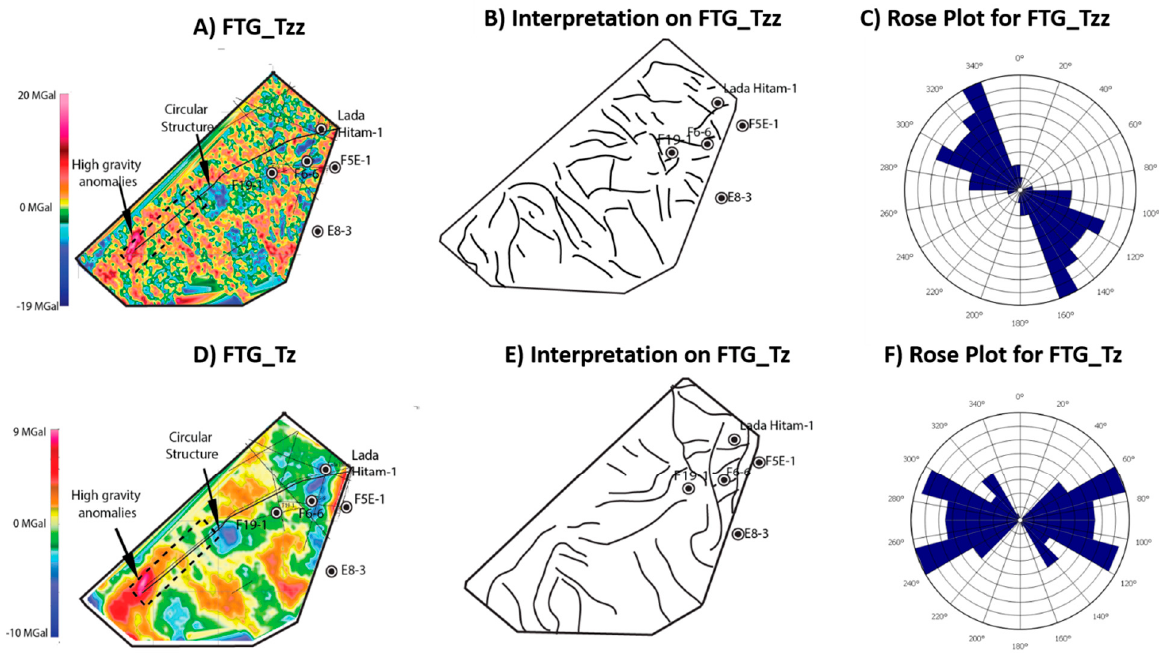
Figure 8. Anomaly map for FTG Tzz (high frequency) data; ( A ) Anomaly map for FTG_Tz. ( B ) Interpretation of structural trends on FTG_Tzz. ( C ) Rose plot diagram for FTG_Tzz showing dominant orientation in NW-SE direction. ( D ) Anomaly map for FTG_Tz (low frequency) data; ( E ) Interpretation of structural trends on FTF_Tz; ( F ) Rose plot diagram for FTG_Tz showing orientations in WNW-ESE and NE-SW with minor NW-SE.